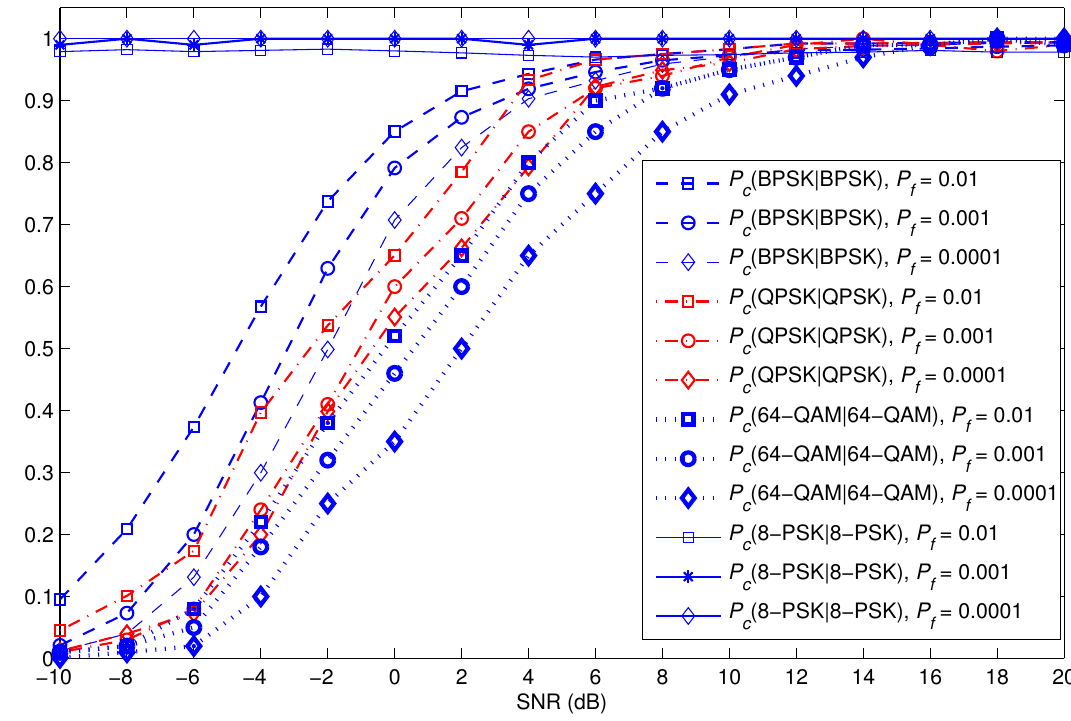
Figure 15. The effect of P f on the categorization performance for the modulation set of Ω 4 . Figures 16–19 display the impact of the number of symbols per frame, N , on the ∑ P c ( Ω = ρ | ρ ) , for Ω = Ω 1 , Ω 2 , Ω 3 , and Ω 4 , average likelihood of categorization, P A = ρ respectively. Increasing N even at moderate or low SNR levels leads to a